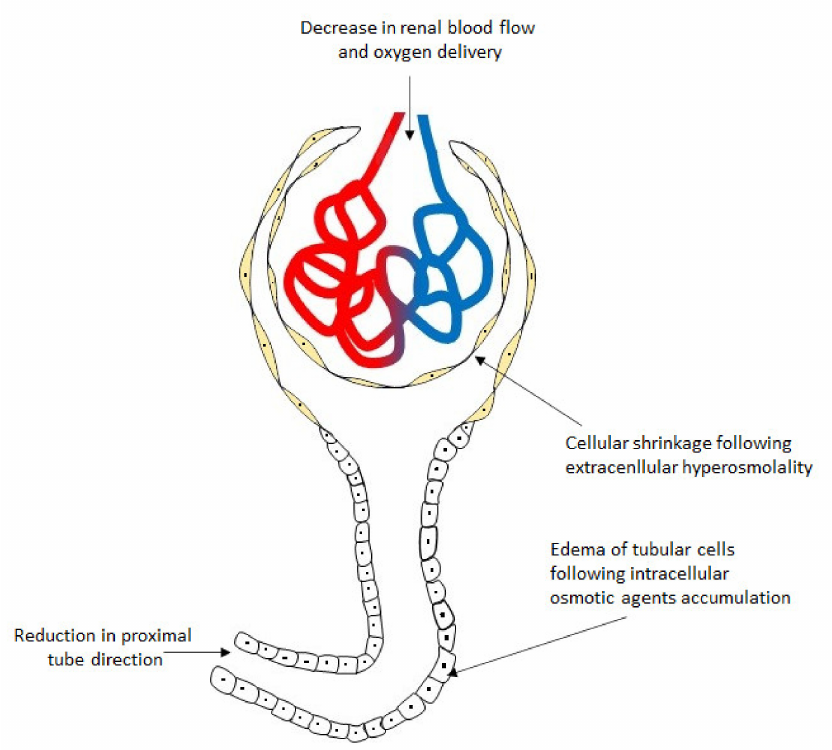
Figure 3. General scheme presenting an effect of hyperosmosis on glomerulus and tubular cells